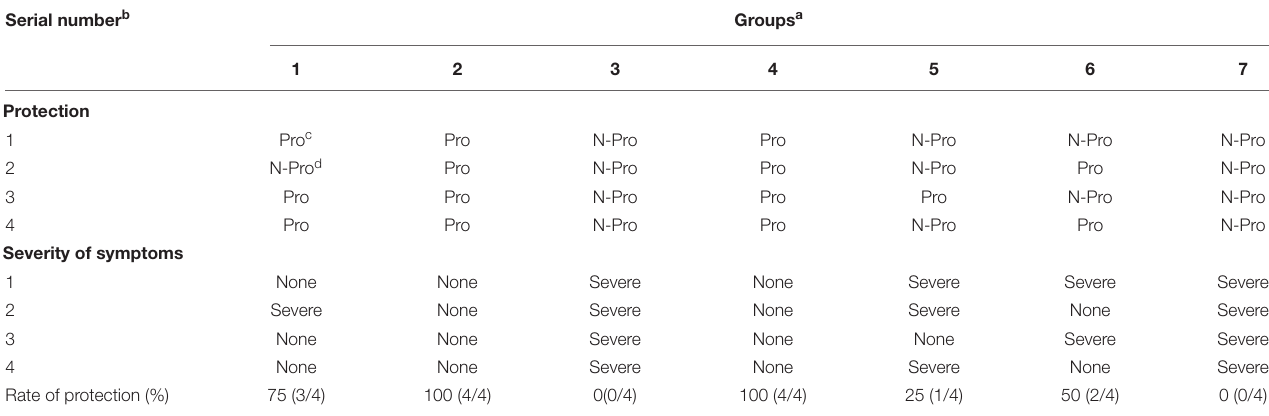
FIGURE 6 | High neutralizing antibody titers and FMDV-specific IgA antibodies were induced in guinea pigs. (A) Neutralizing antibodies in the sera of the intramuscularly immunized guinea pigs were tested with VNT. (B) Anti-FMDV IgA antibodies in the nasal washes of the intraocular–nasally immunized guinea pigs were tested with indirect ELISA. (C) Anti-FMDV IgA antibodies in the nasal washes of the intramuscularly immunized guinea pigs were tested with indirect ELISA. Results are presented as means ± SD ( n = 3). TABLE 3 | Protection of and symptom severity in guinea pigs after challenge with A/GDMM/CHA/2013 strain. Serial number